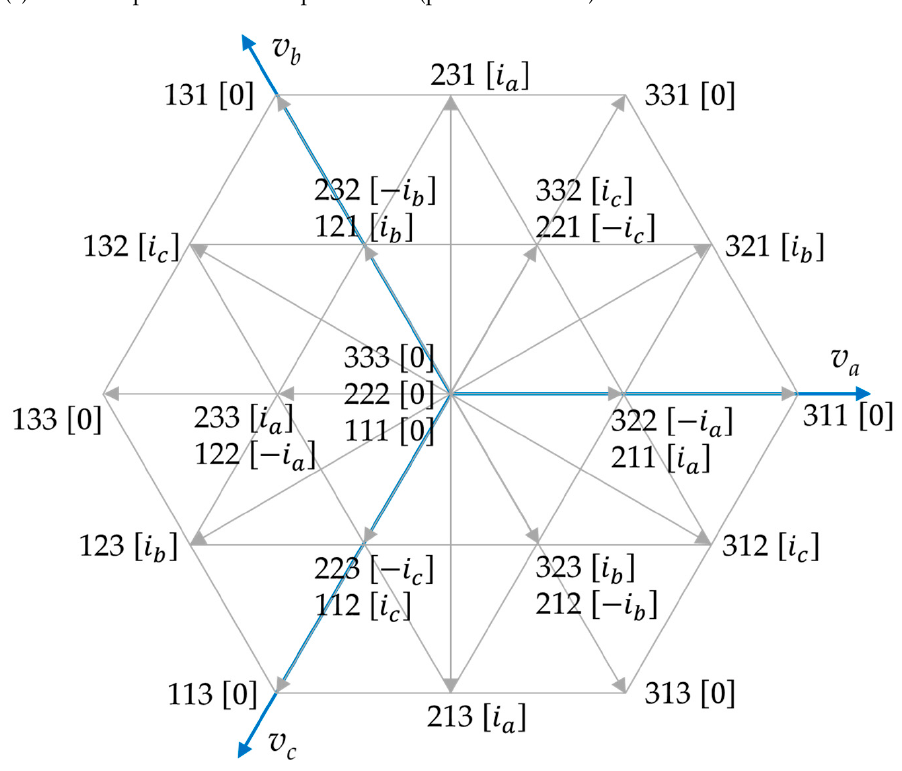
Figure 10. Space vector diagram with neutral-point current information for a 3-level three-phase NPC DC–AC converter.